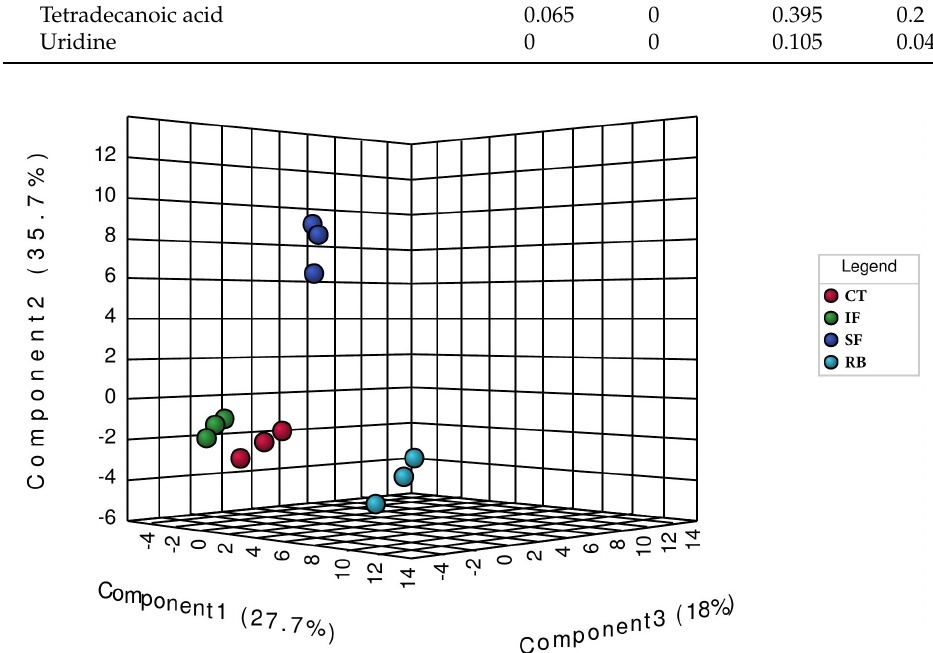
Figure 4. Partial least-squares discriminant analysis (PLS – DA) plot based on the metabolites detected in the feces of different treatment groups (CT = control, RB = rice beverage, IF = insoluble fraction and SF = soluble